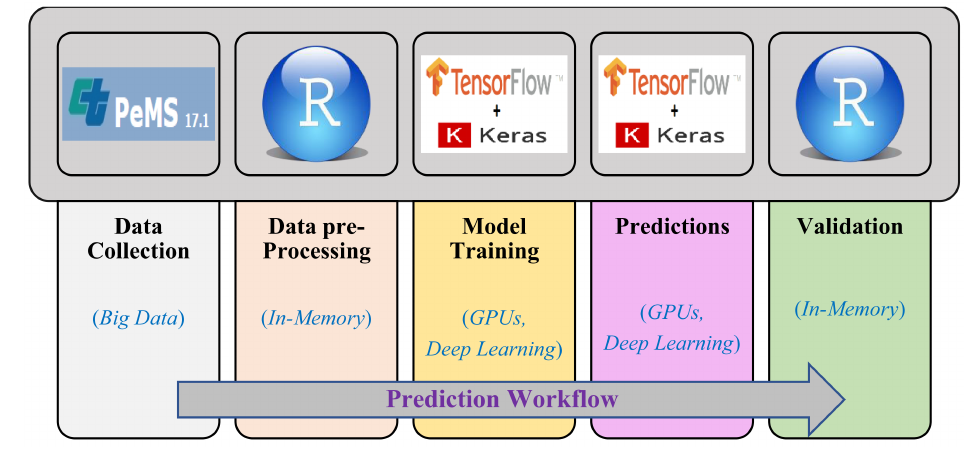
Figure 1. Prediction